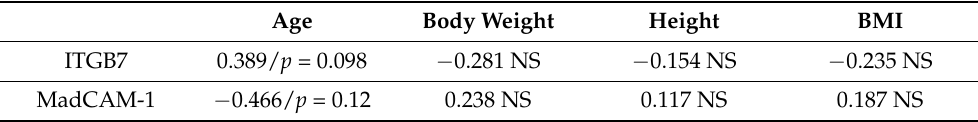
Table 5. Correlations between ITGB7 and MadCAM-1 with basic parameters in controls.